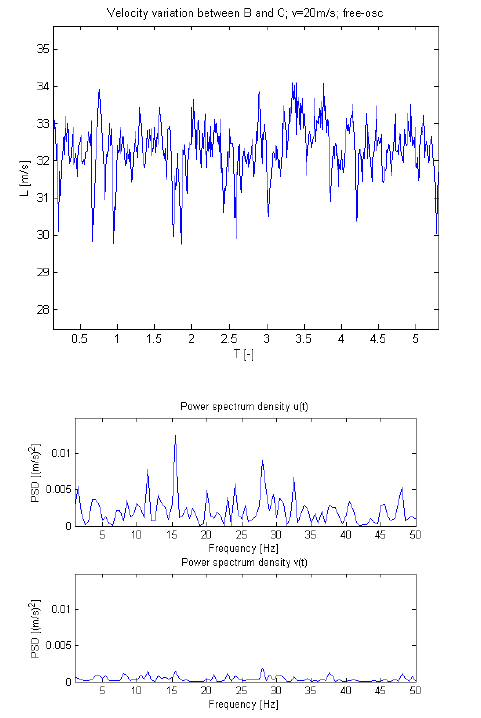
Fig. 5. Velocity variation and freq. spectra for both vel. components at point X for free-oscillating blades (turbine) .